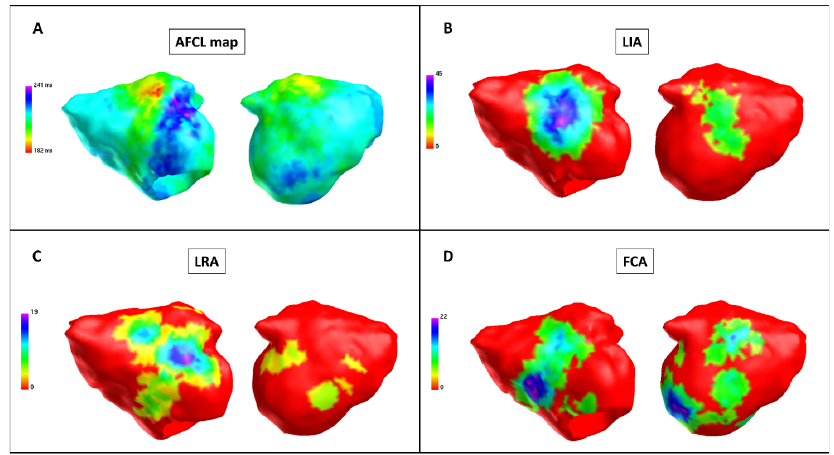
Figure 1. Baseline charge density map (Patient 9). Charge density map with theAcQMap catheter. Each color point on the map corresponds to the color-matched legend on the left. ( Panel A ) Atrial fibrillation cycle length (AFCL) map: left side, anterior-posterior view; right side, posterior-anterior view. An area of a short AFCL in the anterior wall (in red). The AFCL is higher in the posterior and roof regions. Color bar describes AFCL in ms. ( Panel B ) LIA map: left side, anterior-posterior view; right side, posterior-anterior view. Higher LIA number in the anterior and posterior regions. Color bar describes LIA in LIA/s. ( Panel C ) LRA map: left side, anterior-posterior view; right side, posterior-anterior view. Higher LRA number in the anterior and posterior regions. Color bar describes LRA in LRA/s. ( Panel D ) FCA map: left side, anterior-posterior view; right side, posterior-anterior view. Higher FCA number in the anterior and posterior regions. Color bar describes FCA in FCA/s. FCA: focal centrifugal activation; LIA: localized irregular activation; LRA: localized rotational activation.